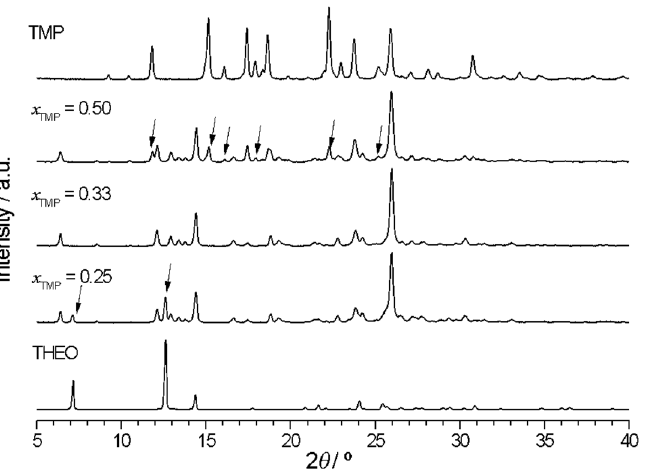
Figure 10. X-ray powder diffractogram of TMP + THEO mixtures of different compositions, obtained by LAG, ethanol-assisted.